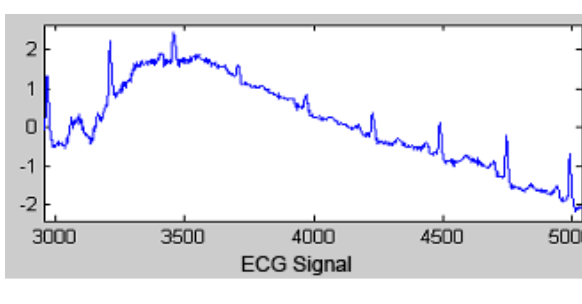
Figure 2. ECG vector with noise.